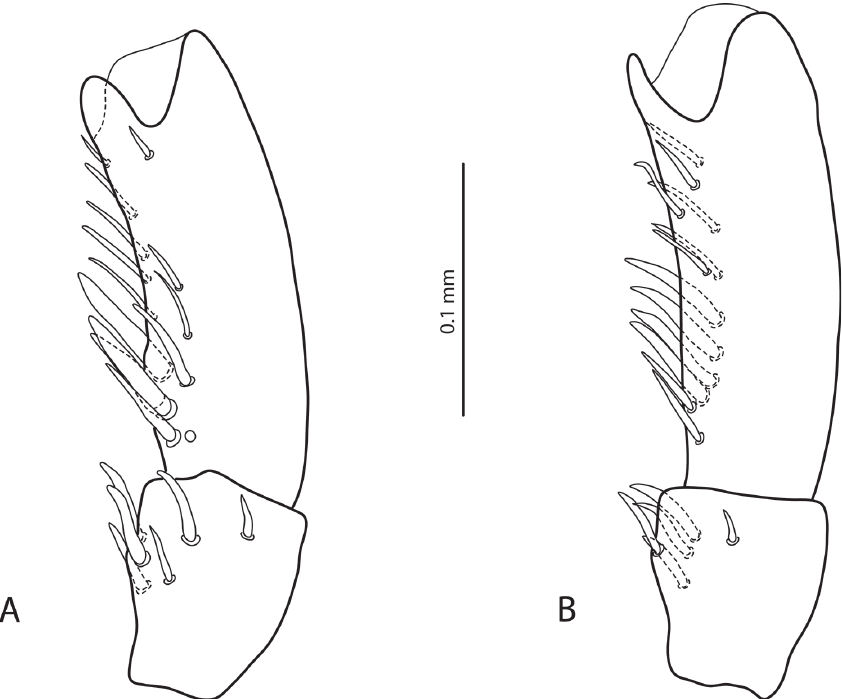
Figure 1. Exocelina manfredi (Balke, 1998), male protarsomeres 4–5 in lateral view A paratype, Borme B